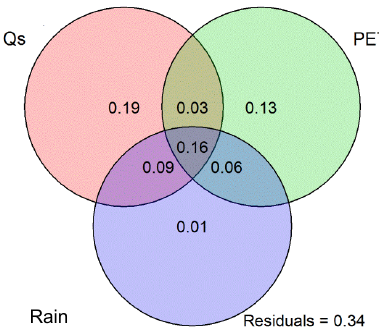
Figure 3. Contributions of critical factors to the spatial variations in Q. Contributions of Q s , PET and Rain to the spatial variations in Q.